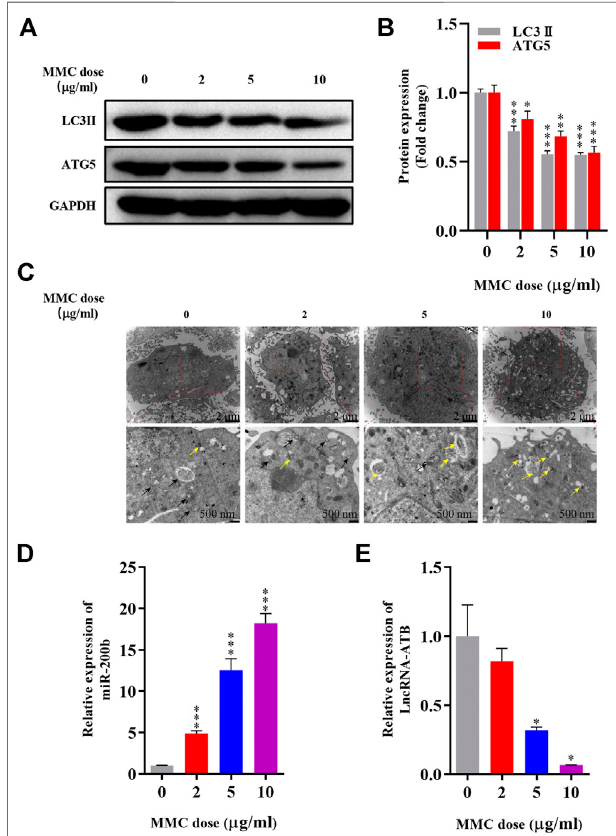
FIGURE 2 | MMC inhibited HEFs autophagy and regulated expression levels of lncRNA-ATB and miR-200b (A) Western blotting was used to determine the expression levels of LC3II and ATG5 with HEFS treated with or without MMC for 24 h (B) Relative protein expression levels of LC3II and ATG5comparedwiththecontrolgroup. (C) Autophagosomesandlysosomes were observed by transmission electron microscope after treatment with MMC at 2, 5, and 10 μ g/ml (D,E) HEFs cells were treated with MMC at 2, 5, 10 μ g/ml, the relative expression of miR-200b and lncRNA-ATB was compared with the control group. Black arrow: Autophagosome; Yellow arrow: lysosome * P < 0.05 ** P < 0.01*** P < 0.001 vs. Control.